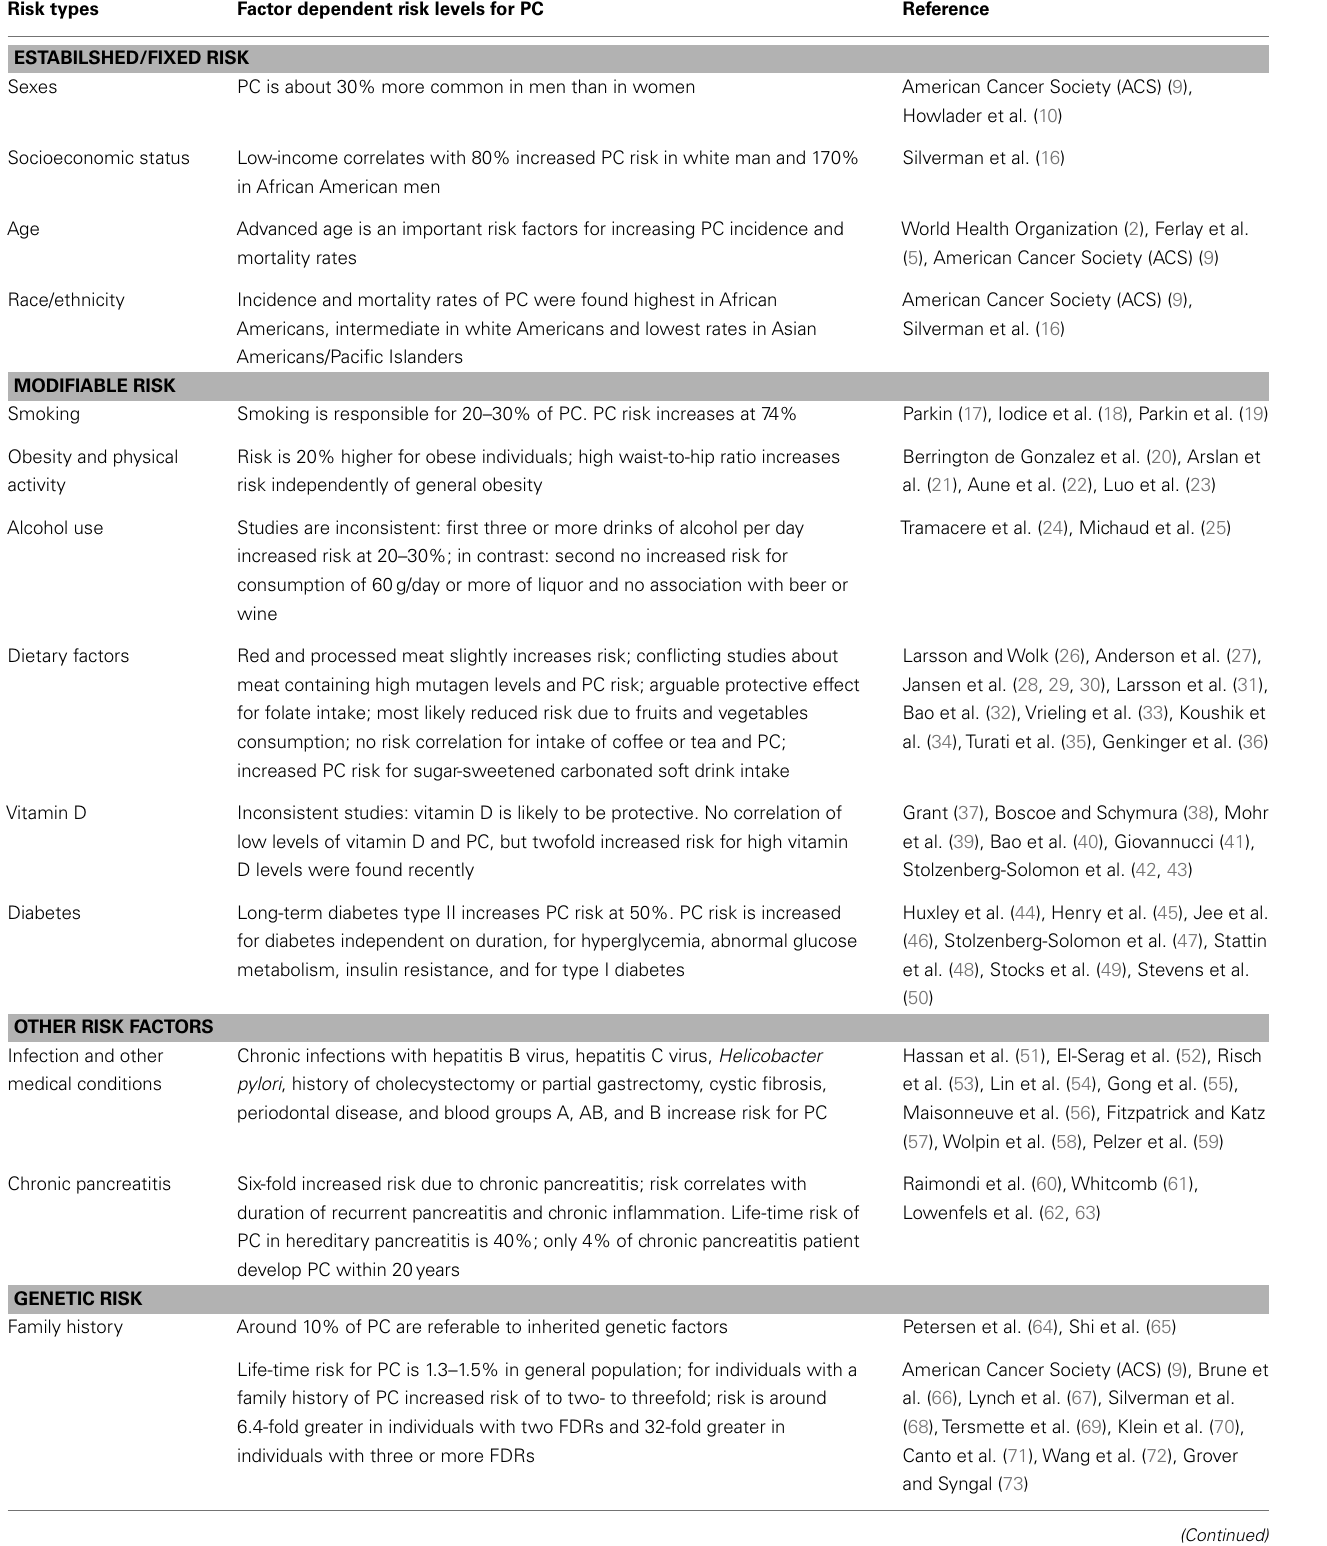
Table 1 | Risk factors for